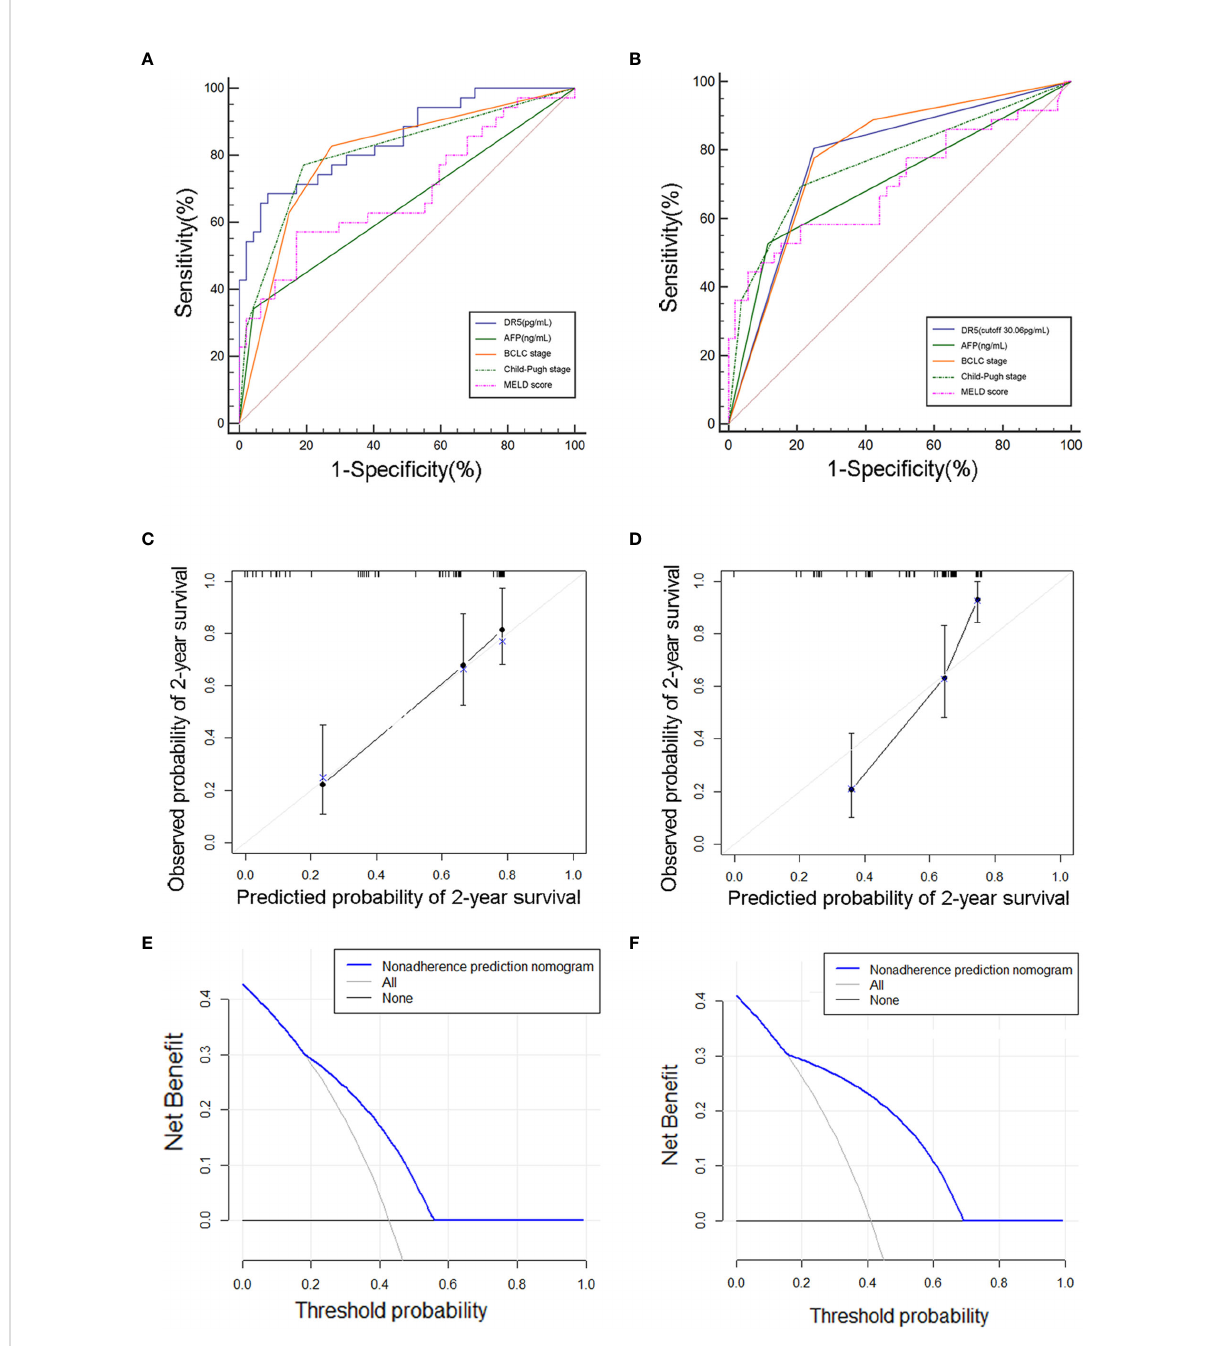
FIGURE 4 Evaluation of the prediction effect of cutoff value of sDR5 in the derivation (A, C, E) and validation (B, D, F) cohorts. (A, B) Receiver operating characteristic curve for the sDR5 and other model or indicators. (C, D) Calibration plot, (E, F) Decision